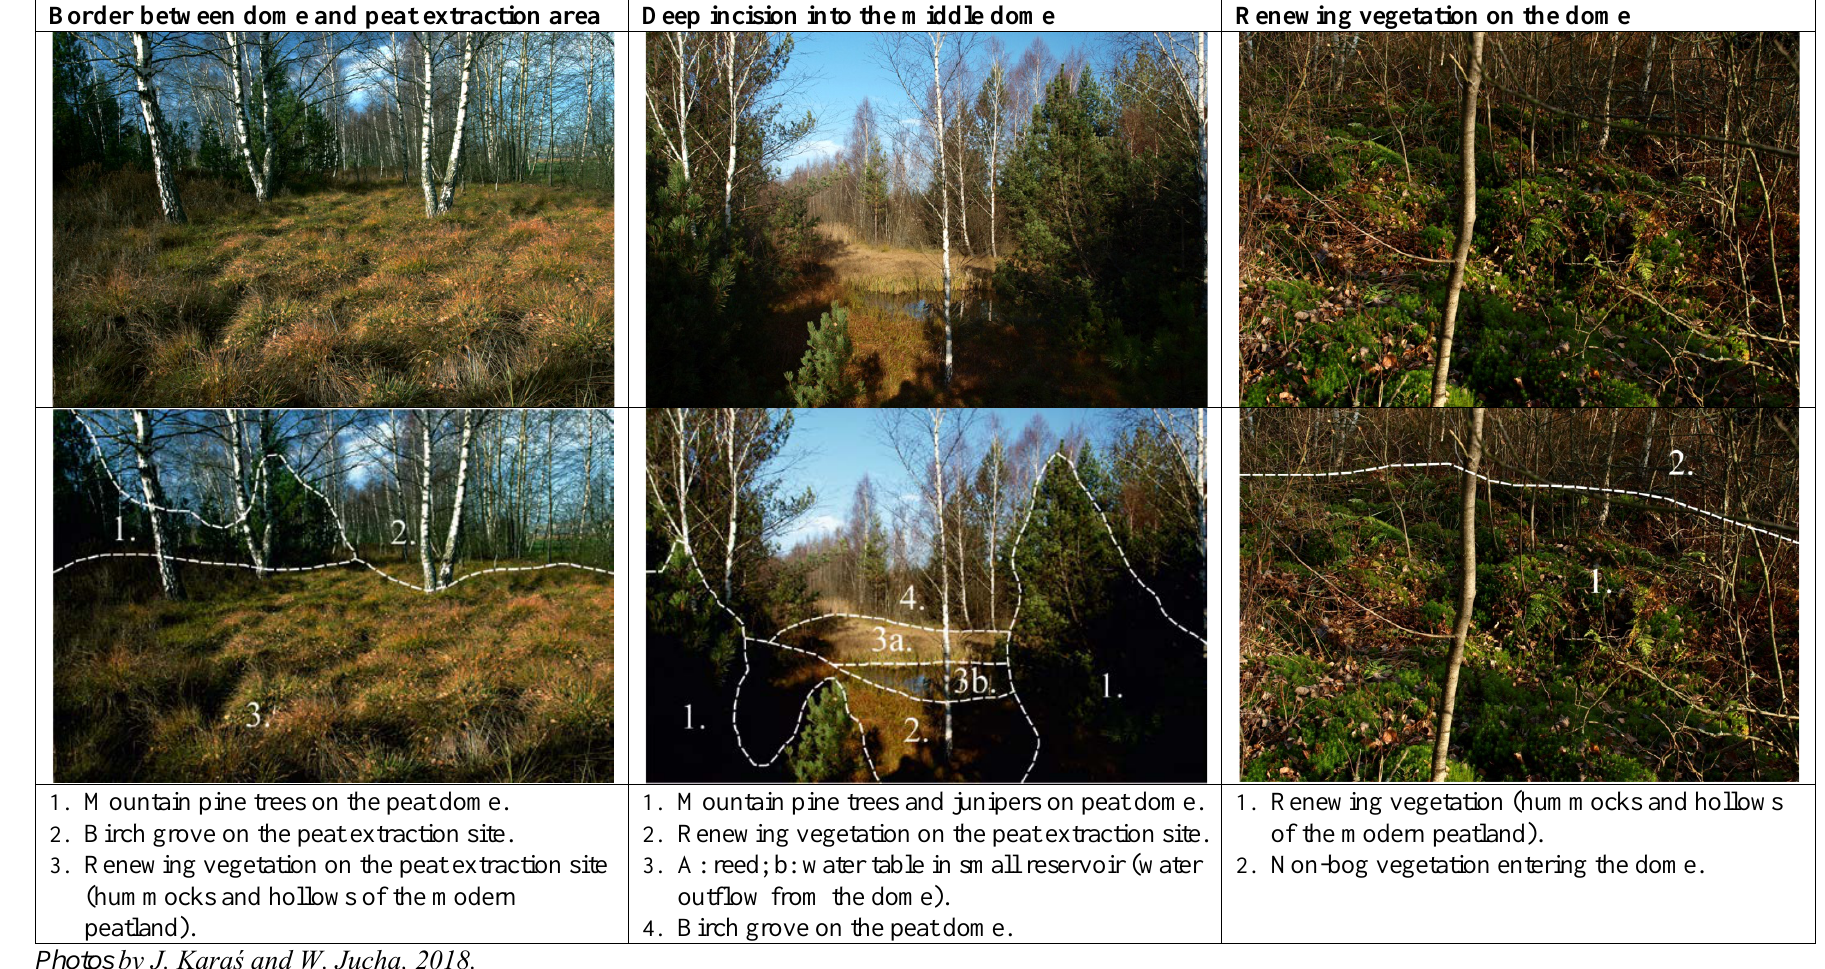
Figure A2. Photographic documentation of vegetation types on domes, peat extraction areas and the border between dome and peat extraction area (examples). Border between dome and peat extraction